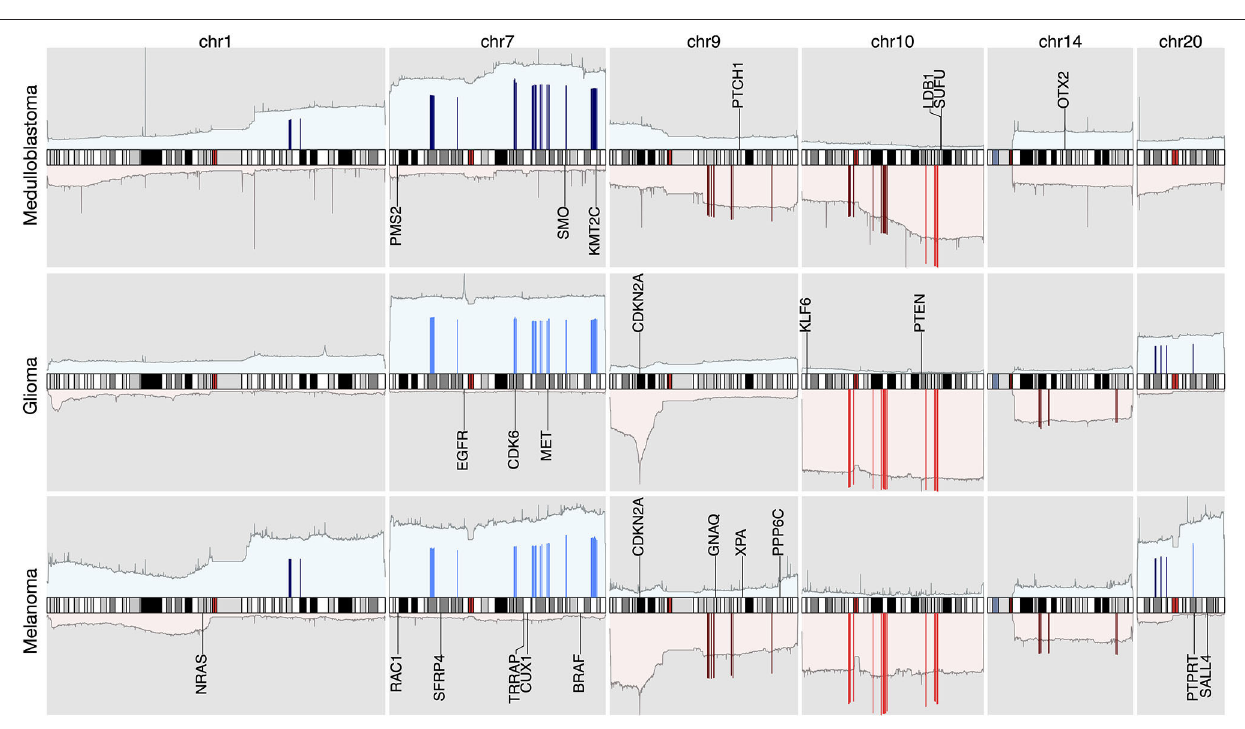
Frontiers in Genetics |